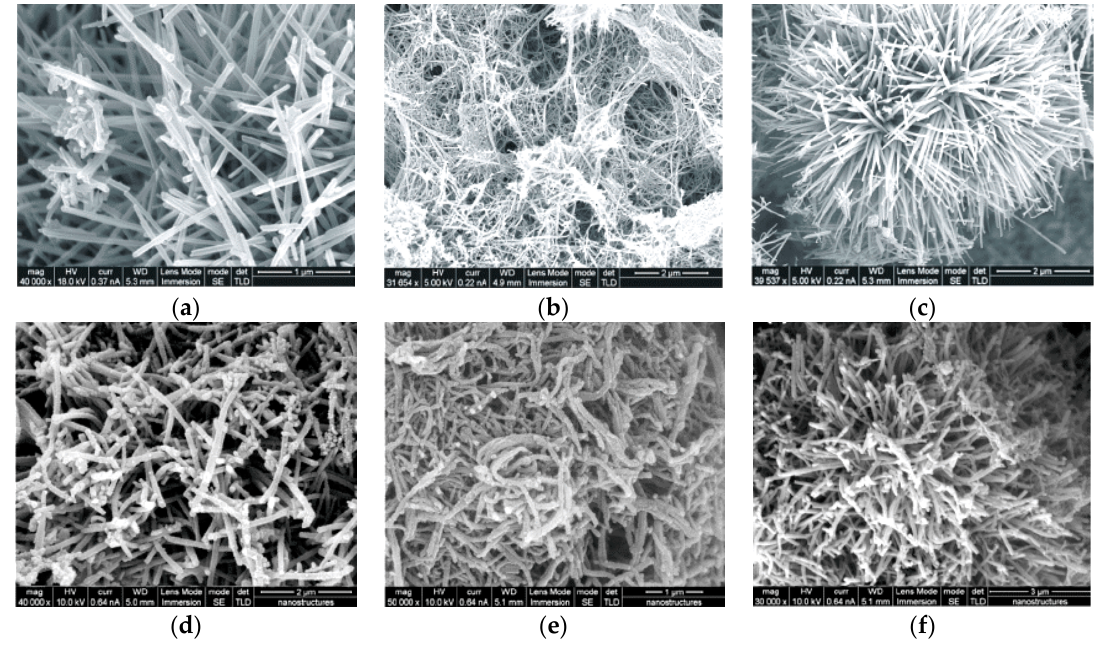
Figure 11. SEM images of three different MnO 2 nanostructures: ( a ) nanorods; ( b ) nanowires; and ( c ) urchins with corresponding morphologies of PPy: ( d ) nanotubes; ( e ) nanofibers; and ( f ) urchins. Reprinted from [65]. Copyright (2017), with permission from Elsevier.